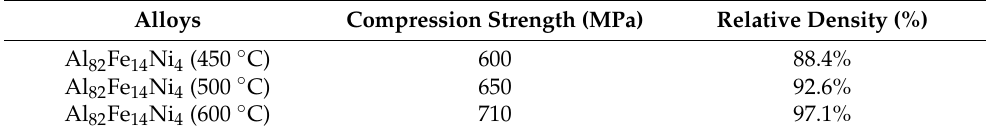
Table 4. Relative densities and compression strengths of the sintered samples.